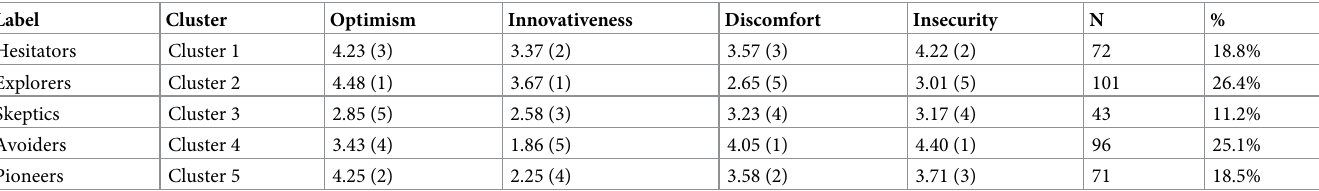
Table 1. Cluster means and ranking.